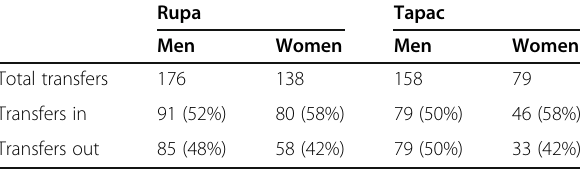
Table 3 Frequencies of exchange by gender and field site Rupa